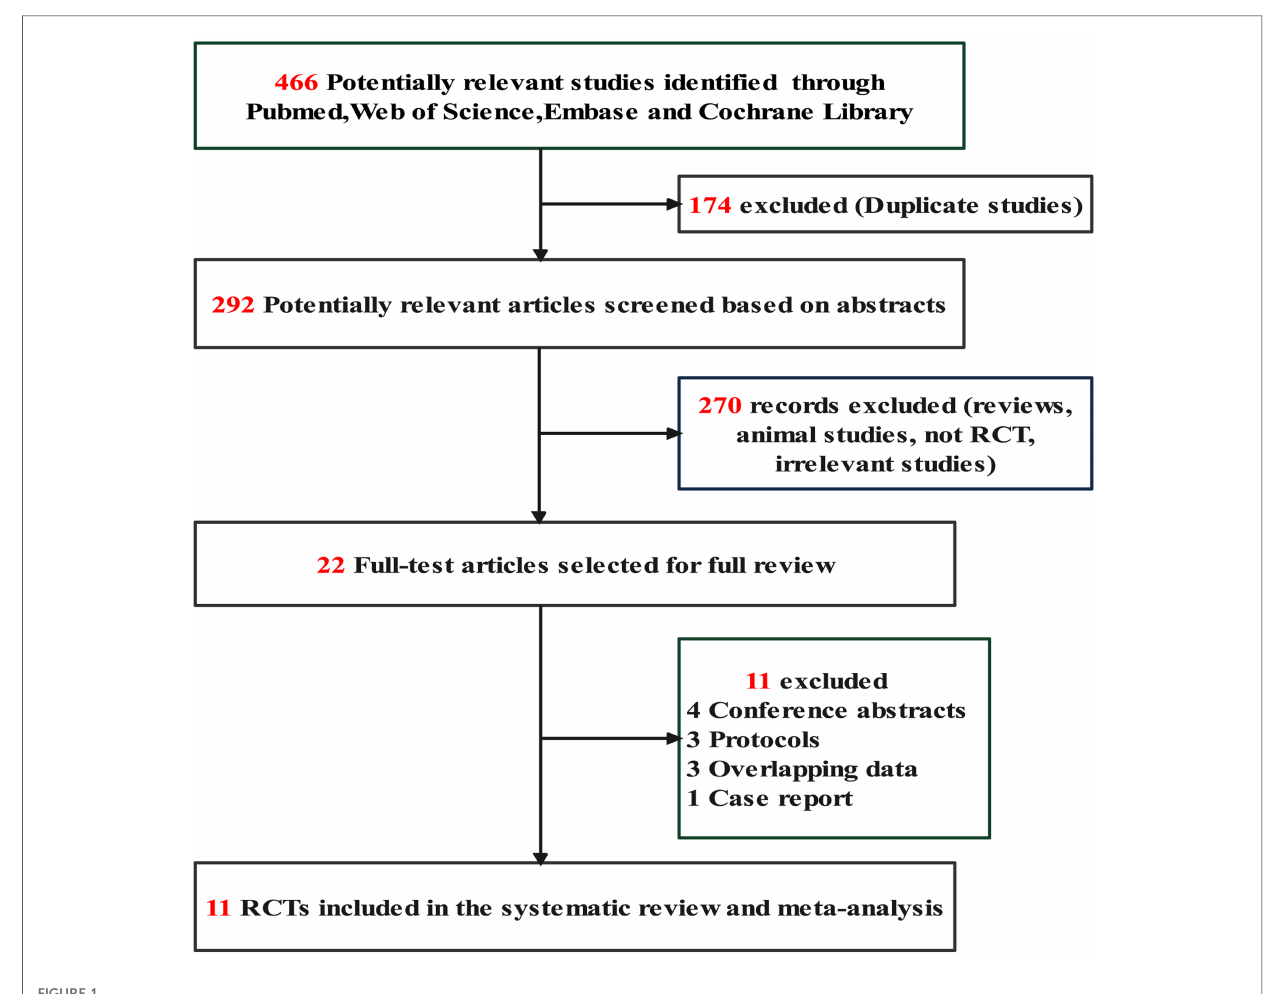
FIGURE 1 Flow chart of study selection. RCT, randomized controlled